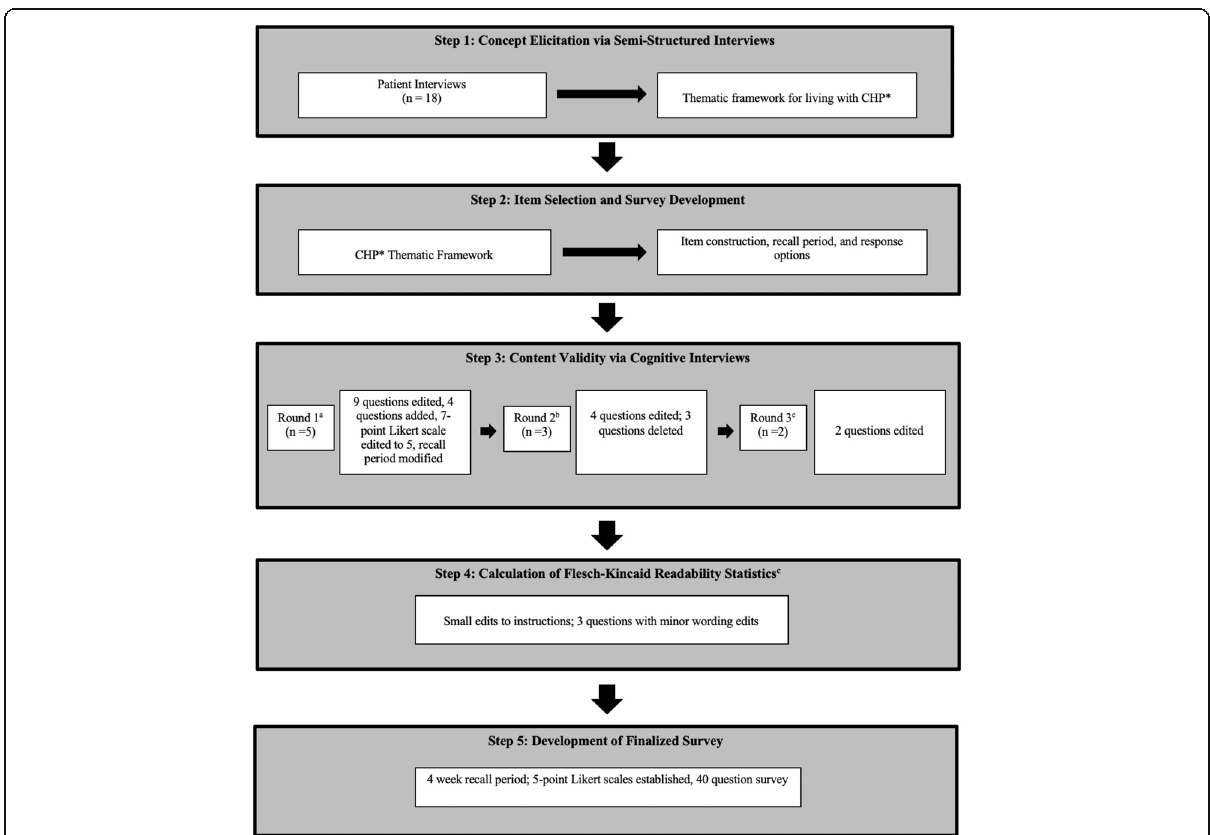
Fig. 1 Methodology of Survey Development Using Cognitive Interviews. Key--*Chronic Hypersensitivity Pneumonitis, a = 39 question instrument, b = 43 question instrument, c = 40 question